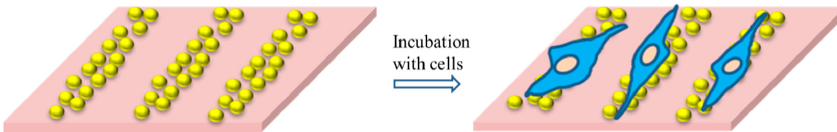
Figure 8. General scheme of the patterned Au NPs stripes on the surface of 8PEG-VS-SH hydrogels to control cell adhesion and spreading.